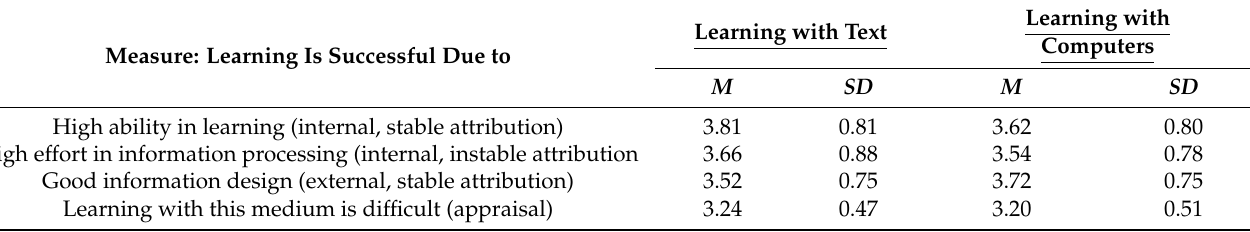
Table 2. Descriptive data of study 1 in media